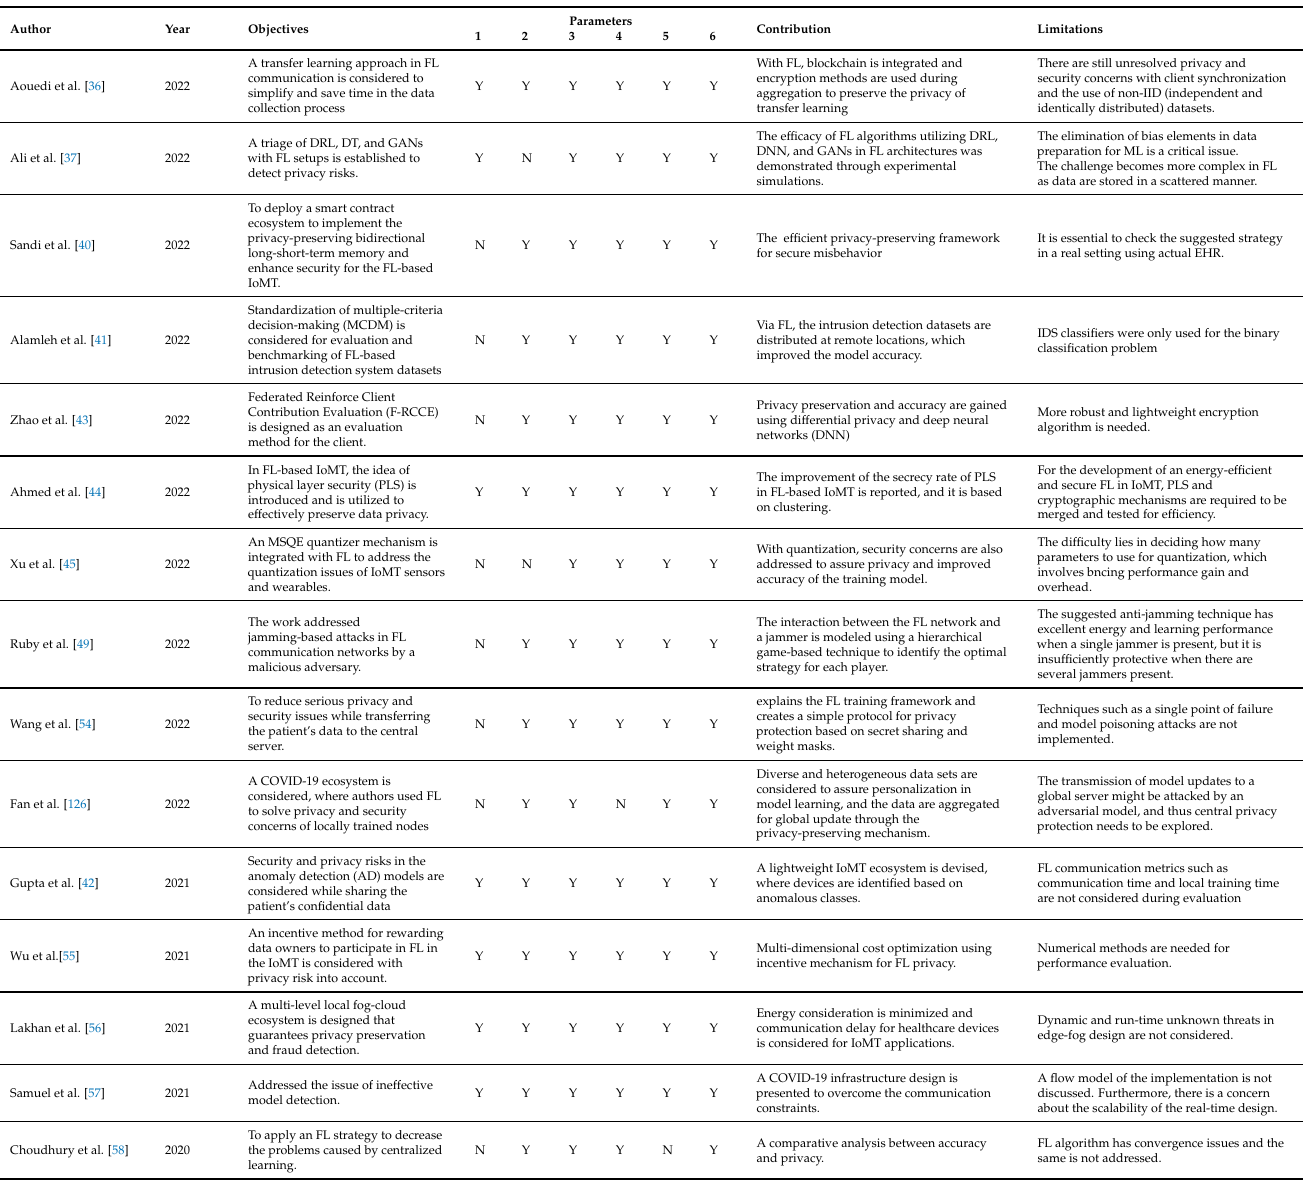
Table 11. A comparative analysis of FL-assisted IoMT